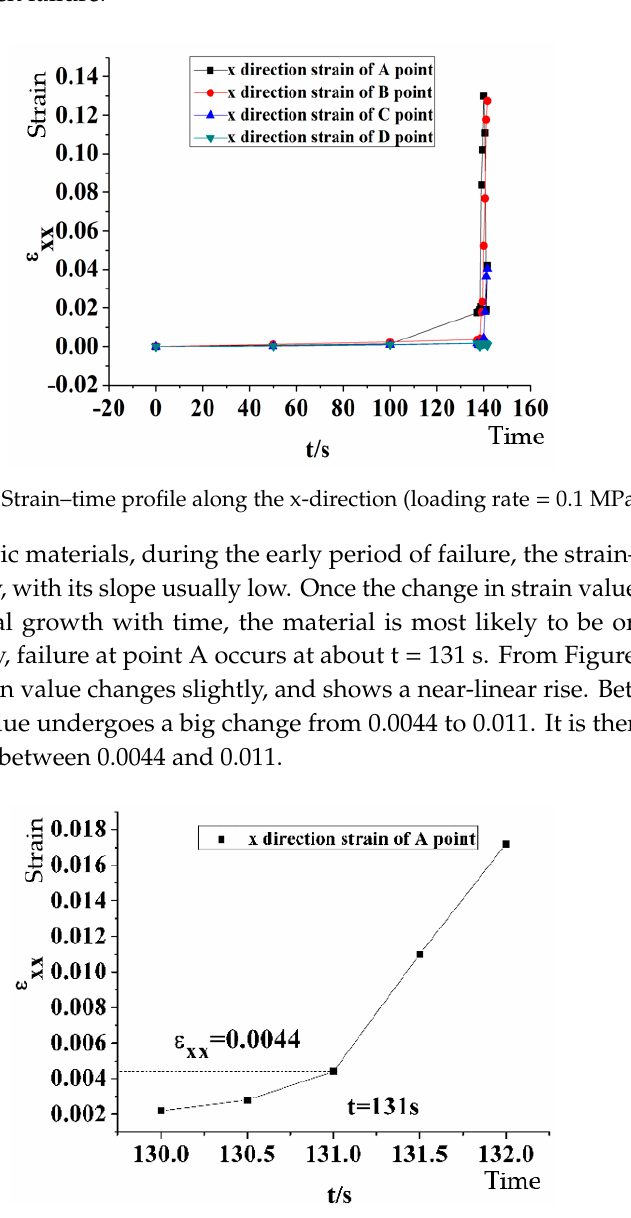
Figure 7. X-direction strain–time relationship at point A (loading rate = 0.1 MPa/s).